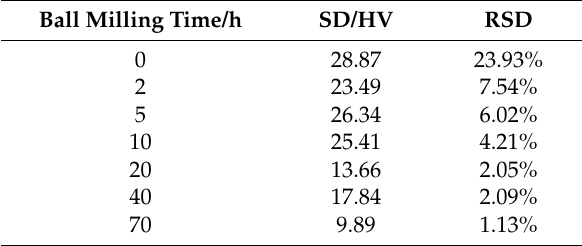
Figure 10. Vickers microhardness of milled powder particles at 500 rpm as a function of milling time. Symbols of different types/colors at the same ball milling time in the figure mean that the same sample was measured several times to reduce experimental error. Table 1. SD and RSD of the hardness value under different milling